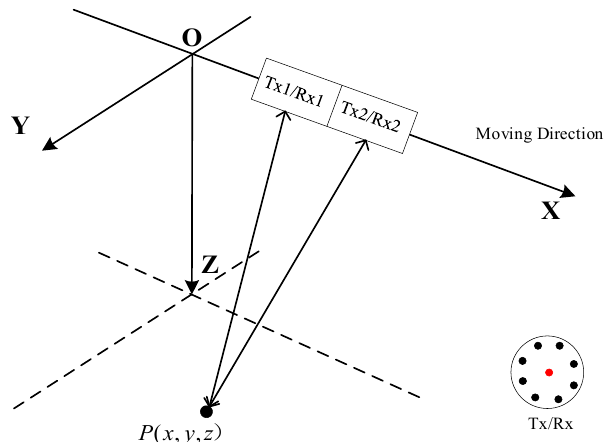
Figure 1. Geometry of the orbital angular momentum (OAM)-based multi-input multi-output (MIMO)-SAR system.